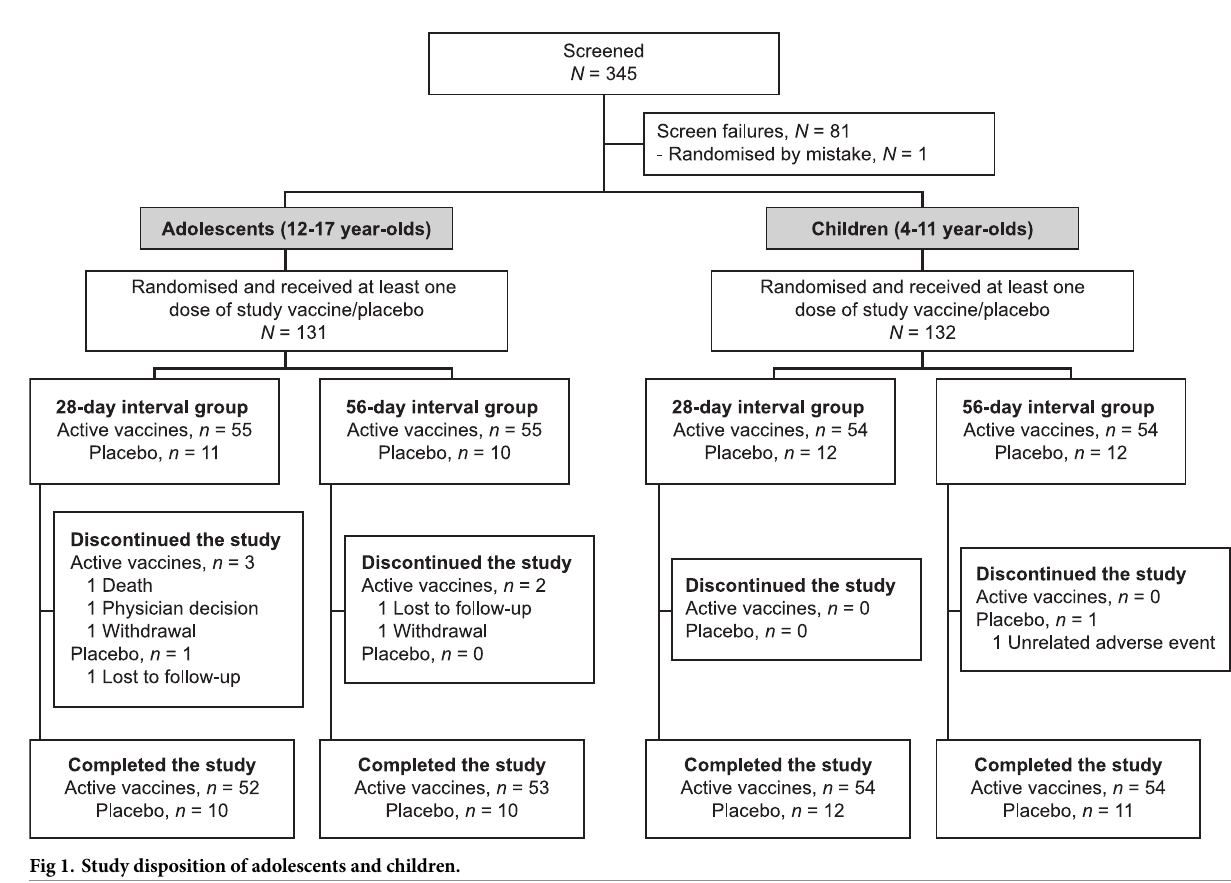
Fig 1. Study disposition of adolescents and children.